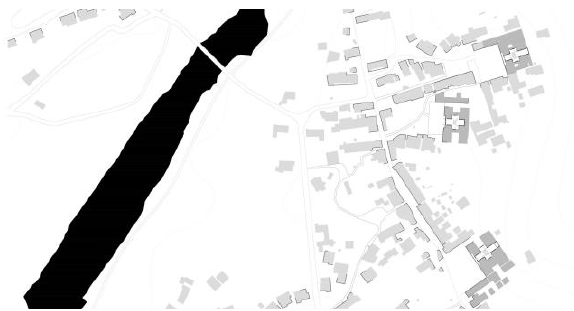
Figure 15. The spatial principles of vernacular architecture in relation to the built form. Elaboration by the first author.